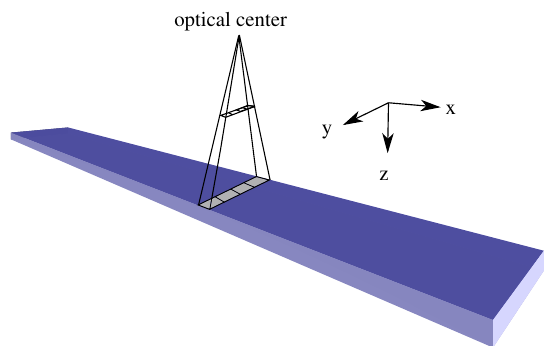
Figure 1. Pushbroom sensors are optical sensors consisting in a line of pixels. They are usually moved orthogonally to the line to construct images.